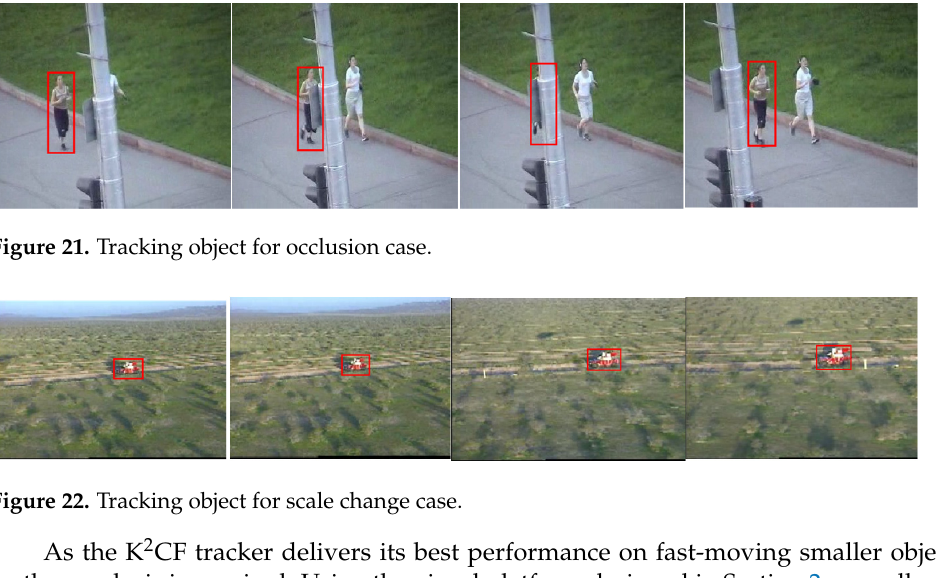
Figure 22. Tracking object for scale change case.